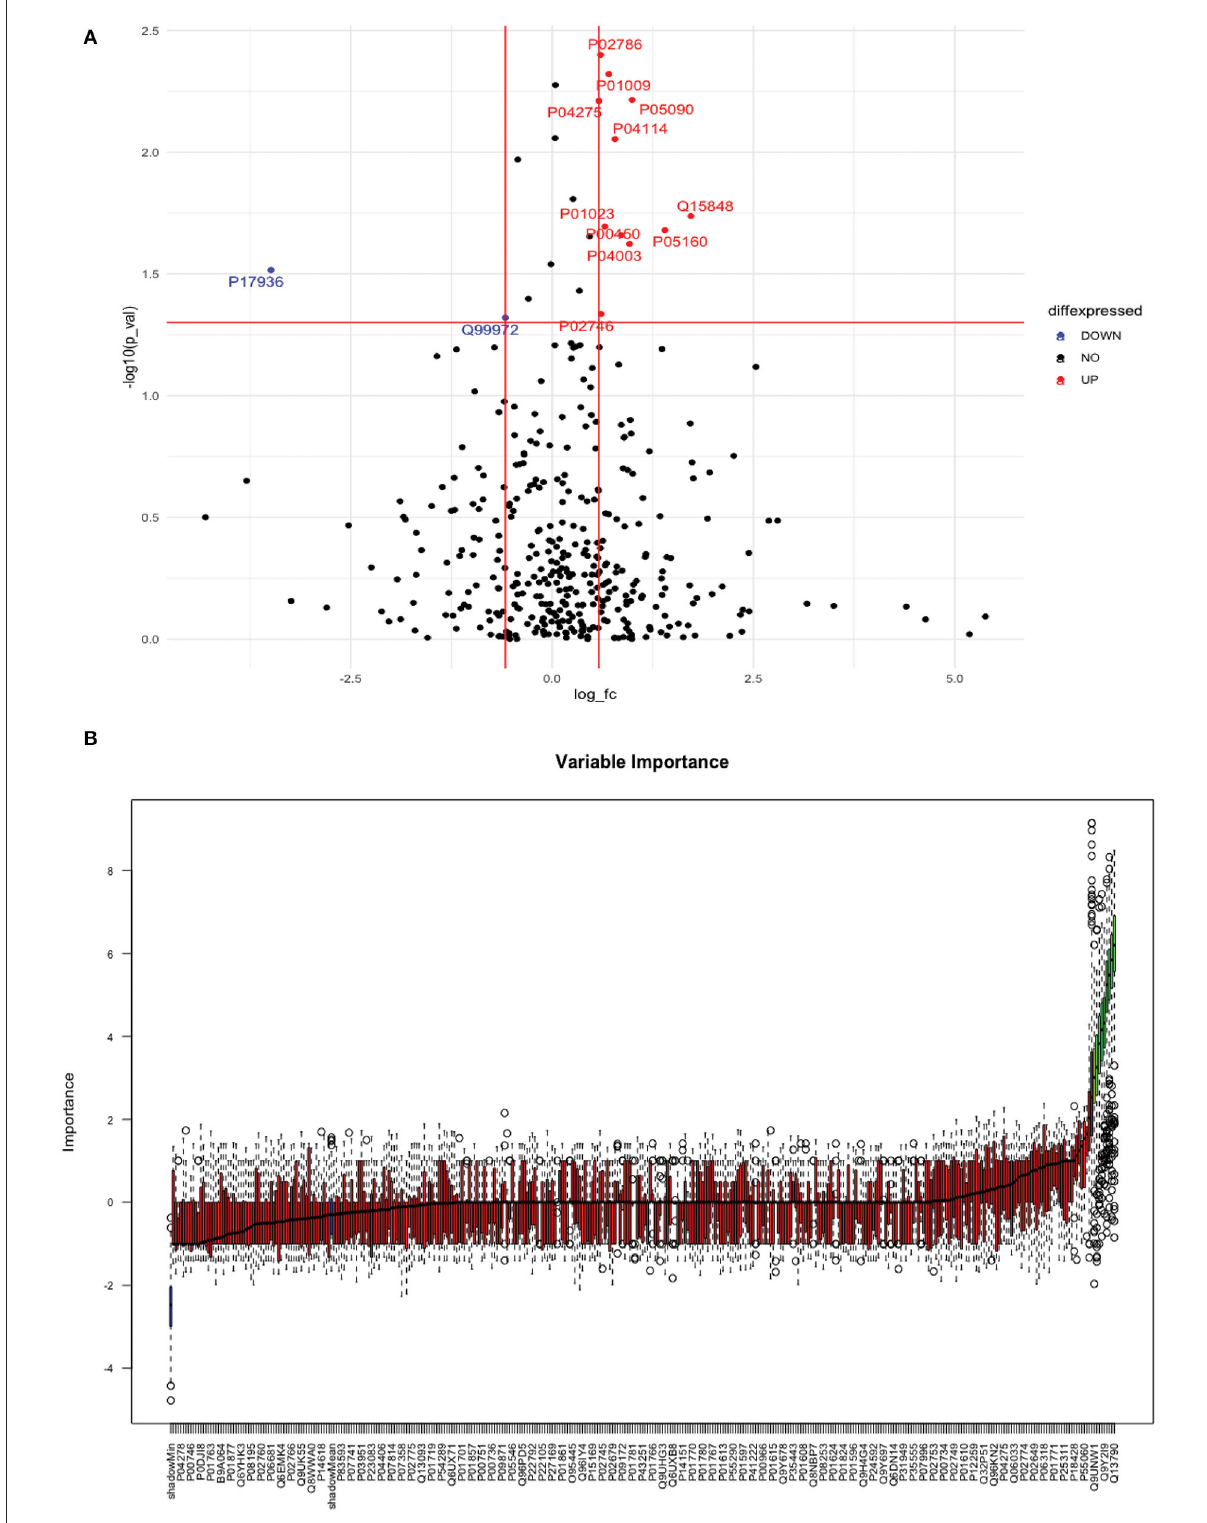
FIGURE5 (A) Volcano plot depicting the log2 fold change on the x-axis and –log10 p- value on the y-axis for the upregulated and downregulated proteins in 20 IS cases compared to 20 healthy controls. (B) Feature selection using the Boruta random forest depicting important features/proteins to differentiate 20 IS and 20 healthy